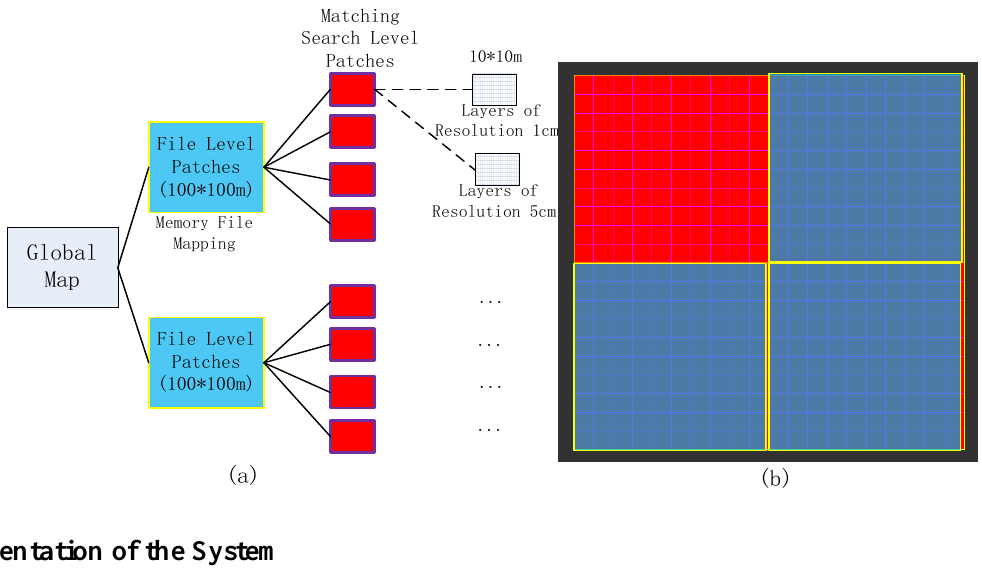
Figure 5. ( a ) The spatial grid-indexed likelihood map structure and ( b ) the overview map of Patch-divided data structure with